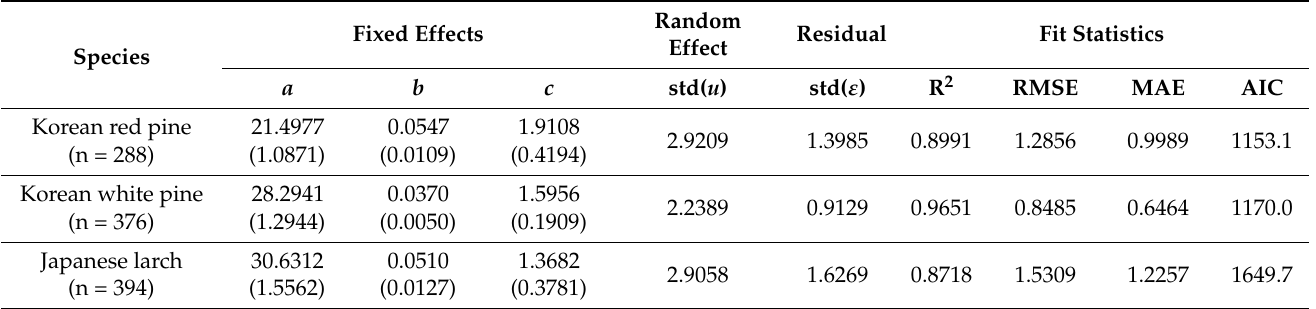
Table 3. Parameter estimates and fit statistics of the dominant height model using the Chapman– Richards function for the site index estimation by